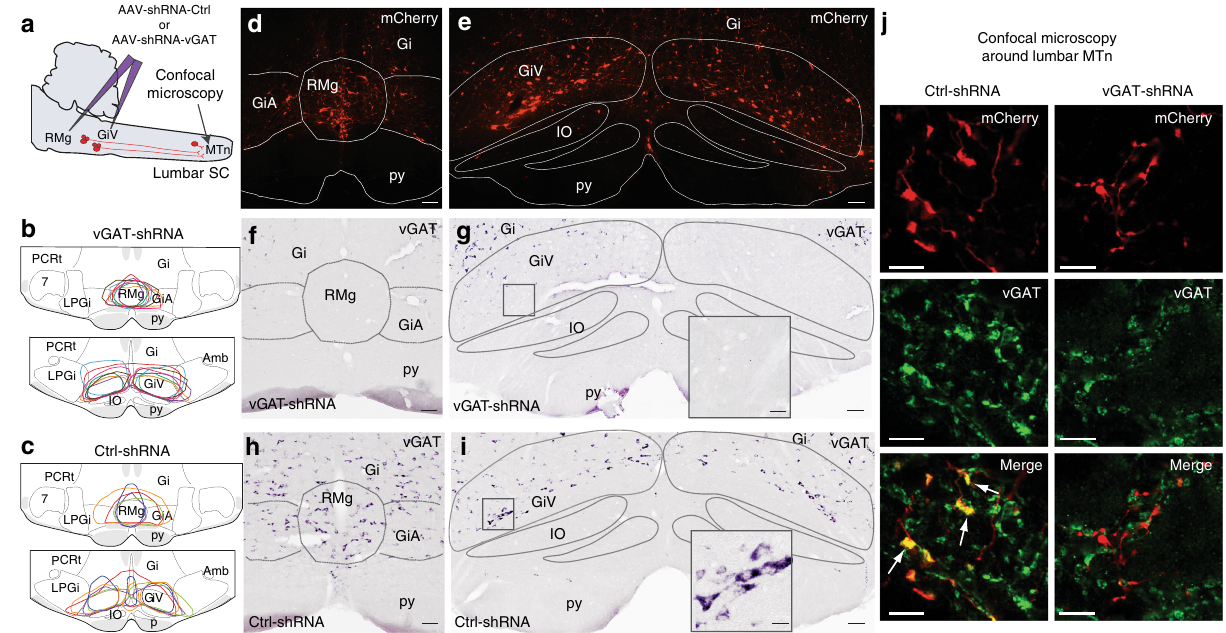
Fig. 3 Veri fi cation of the genetic inactivation of endogenous vGAT mRNA and native vGAT protein in GABA/glycine vmM neurons. a Scheme of the in vivo experiments: AAV-shRNA injections were made in three points to genetically inactivate GABA/glycine neurons present bilaterally in the GiV, and GiA and the midline RMg and to trace anterogradely their efferent projections of transducted neurons until the lumbar spinal cord. b , c Drawings reporting the location and the extent of AAV injection sites at day 30 post-injection for each Ctrl-shRNA ( b , n = 5) and vGAT-shRNA ( c , n = 7) treated rat considered for the physiological study. The injection spreading was demarcated by the spontaneous mCherry fl uorescence. Notice that for these rats, the AAV injections covered the largest part of the vmM and avoided the LPGi laterally and Gi dorsally. d , e Low power photomicrographs of the RMg/GiA ( d ) and the GiV ( e ) in a representative control rat showing the high number of transducted neurons after AAV injection. h , i Photomicrographs of adjacent sections treated for vGAT mRNA ISH. Notice the high number of strongly labeled neurons in RMg, GiA, and GiV indicating that the expression of vGAT mRNA is normal. f , g Photomicrographs of vmM sections taken from a representative vGAT-shRNA rat after the ISH labeling of vGAT mRNAs. Note the absence of labeled neurons in RMg, GiA, and GiV within the injection site. j Confocal photomicrographs comparing in representative Ctrl-shRNA (left) and vGAT-shRNA (right) rats the expression in lumbar motoneurons pool of the native vGAT protein (green, middle panels) in synaptic terminals emanating from transducted vmM neurons (mCherry, top panels). As evidenced on merged photomicrographs, the vGAT protein is expressed in axons and synaptic terminals (arrows) emanating from vmM neurons in Ctrl-shRNA rats (yellow, bottom left panel) but is virtually absent in vGAT-shRNA rats (bottom right panel). Scale bars: 100 µ m in b , c ; 40 µ m in enlarged squares; 5 µ m in